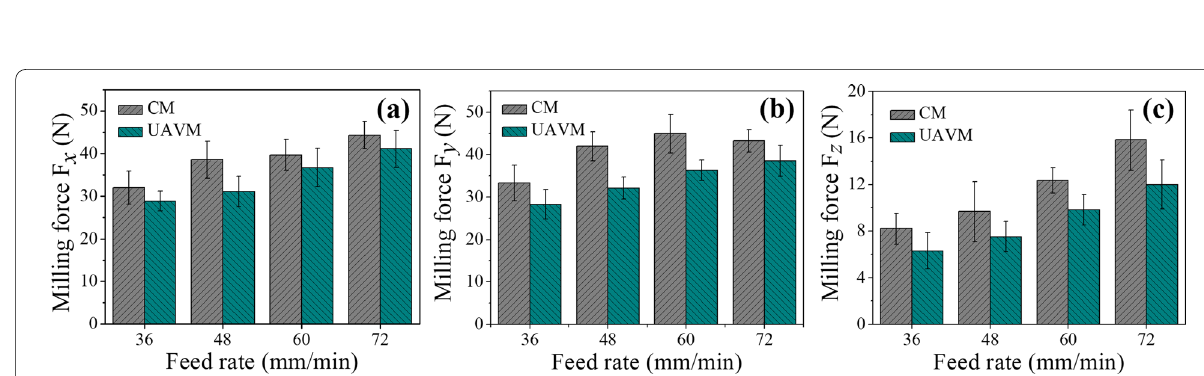
1200 r/min): a F x , b F y , and c F z =